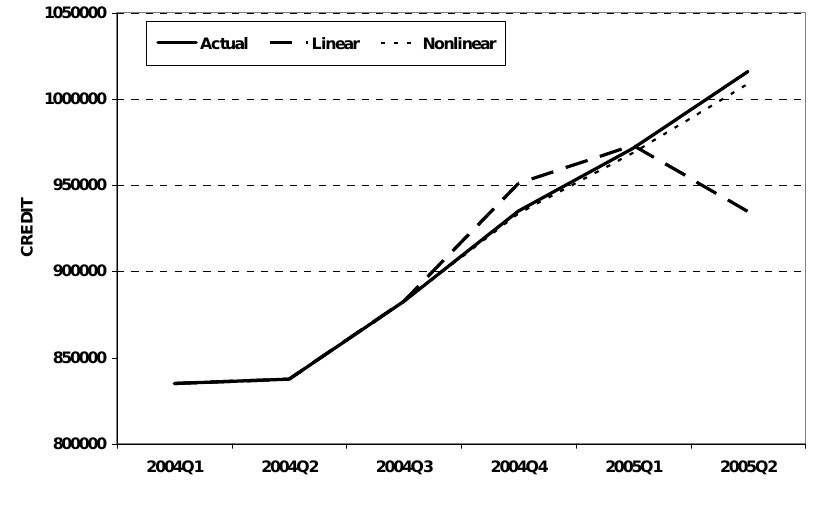
FIGURE 2: Actual data vs. linear model vs. non-linear model (CREDIT)